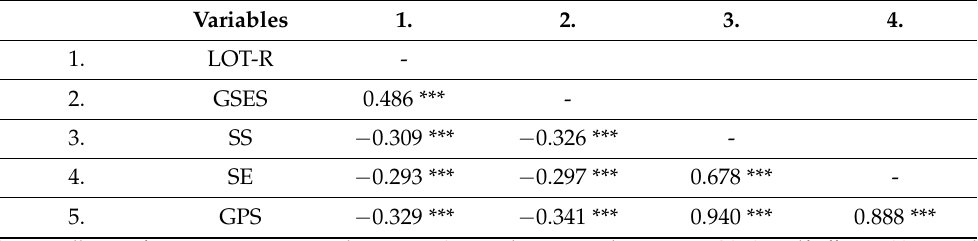
Table 3. Pearson correlation (r) coefficient matrix between the variables under analysis. Variables 1. 2. 3.